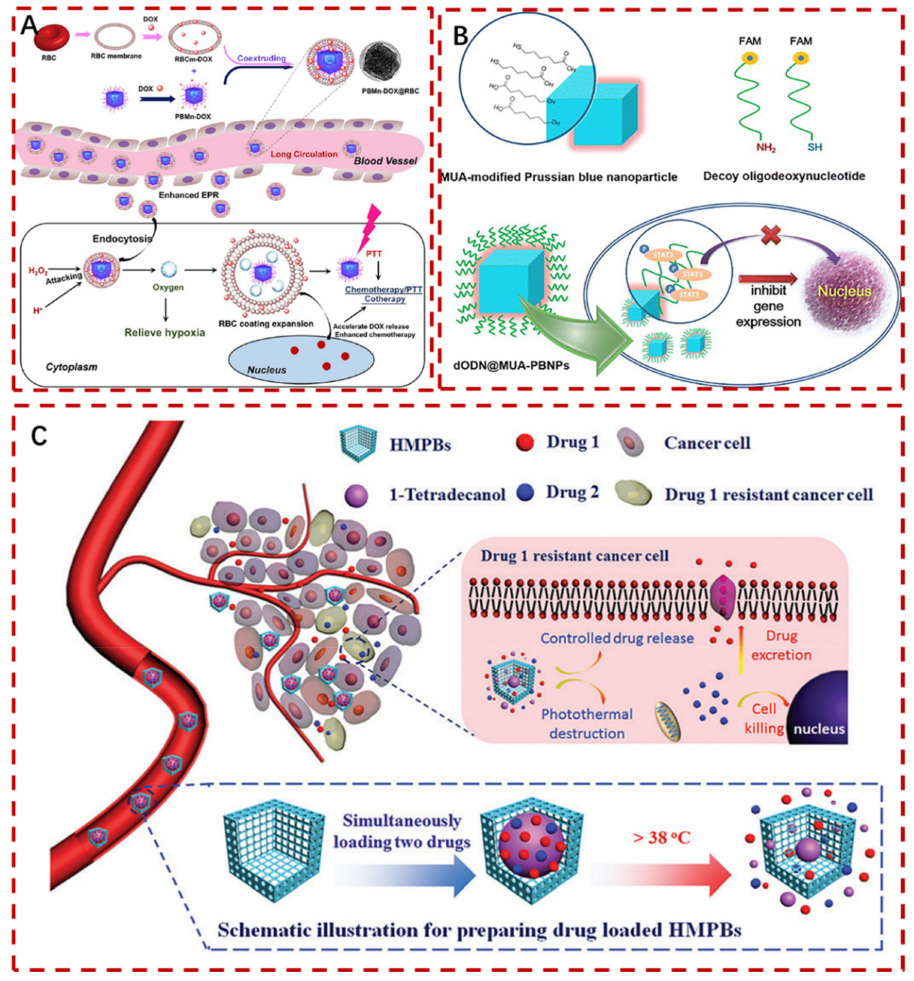
Figure 9. ( A ): Preparation of PBMn DOX@RBC nanocarriers and improvement of breast can- cer chemotherapy/PTT to overcome tumor microenvironment limit [97]. ( B ): Schematic illus- tration of the dODN@MUA − PBNPs delivers drugs to cancer cells by coupling with DNA [98]. ( C ): (PCM+drug)@HMPB system as anticancer medications that are both hydrophobic and hy- drophilic, in combination with photothermist − chemotherapy treatment of cancer [99].